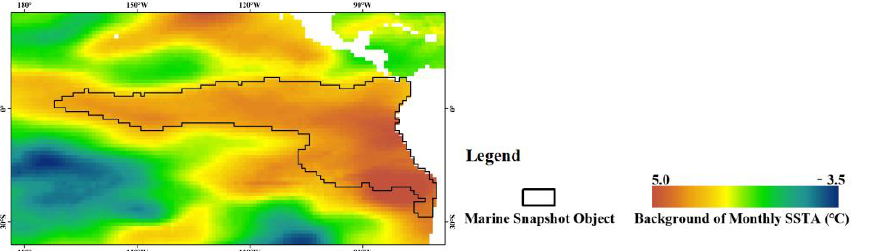
Figure 12. Sequence object 5 continues to decrease in the Equatorial Eastern Pacific Ocean from June to December 1998. The background is the monthly SSTA.